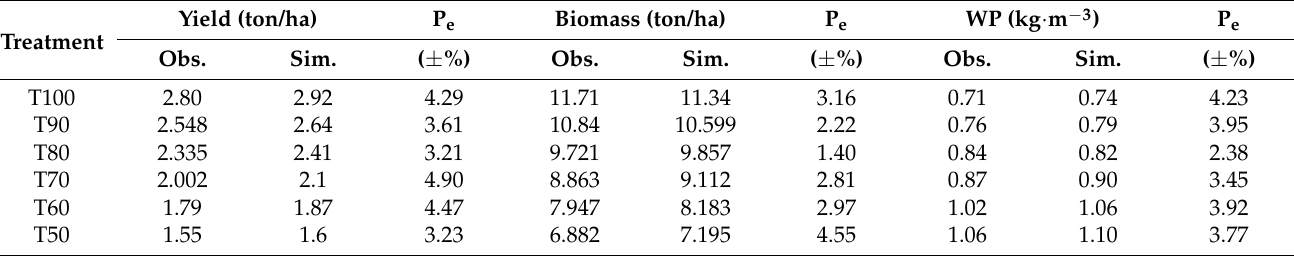
Table 7. The results of model calibration for grain yield, biomass, and water use efficiency for the barley crop under different irrigation conditions